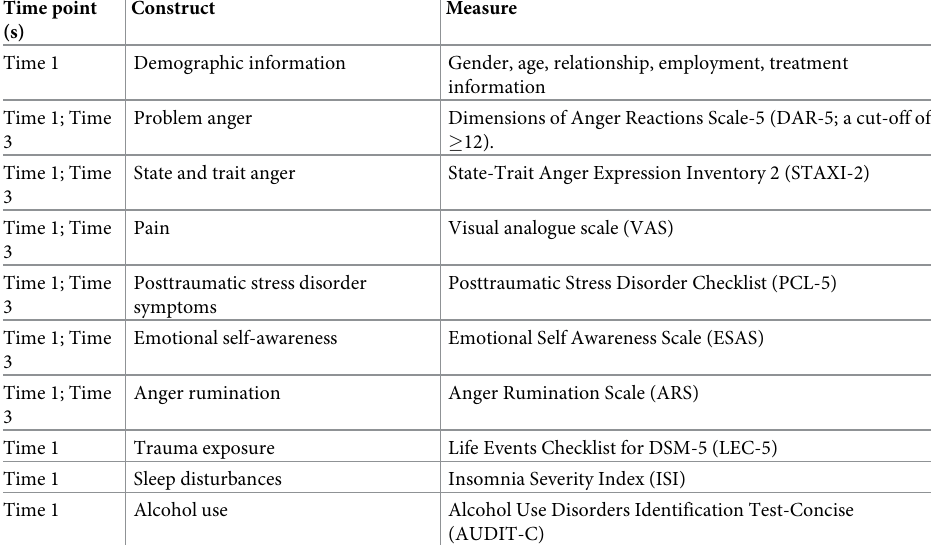
Table 3. Overview of pre- (Time 1) and post- ambulatory assessment (Time 3)